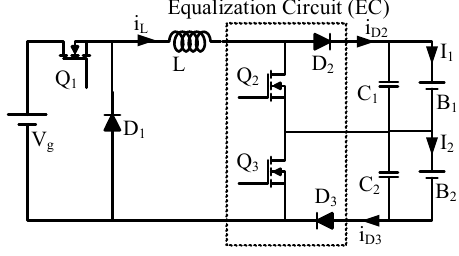
Figure 1. Circuit configuration of the proposed